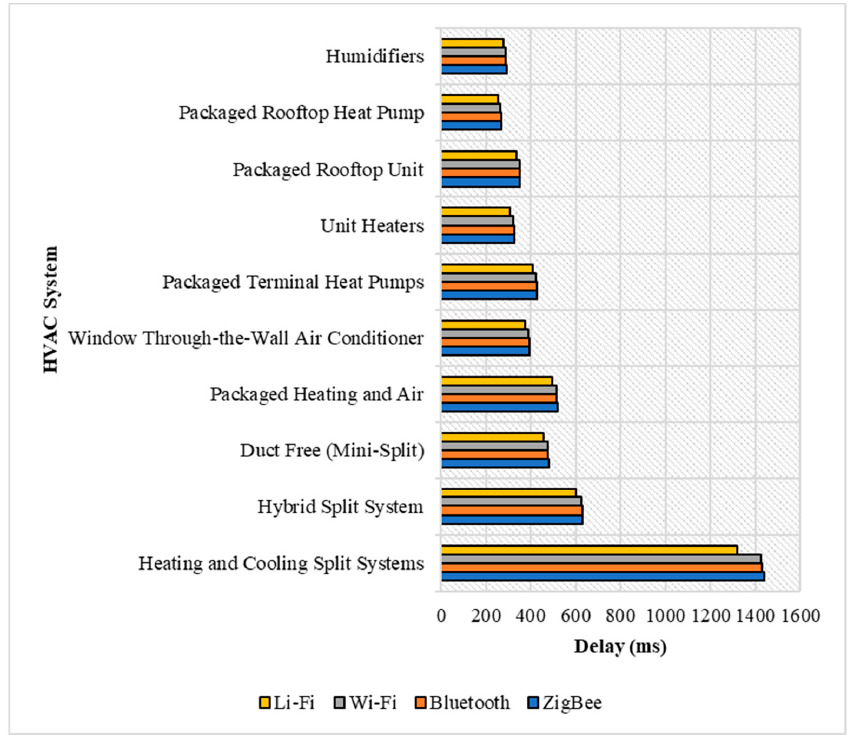
Figure 3. Delays (ms) between various communication protocols using the Convolutional Recur- rent Neural Network system. Neural Network